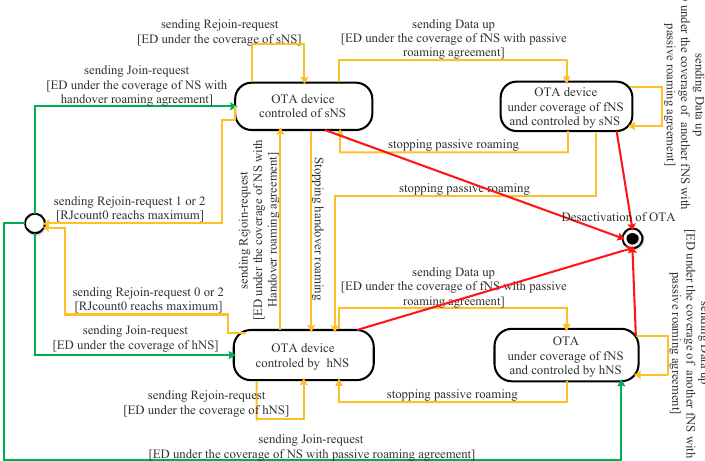
Figure 8. States of an OTA